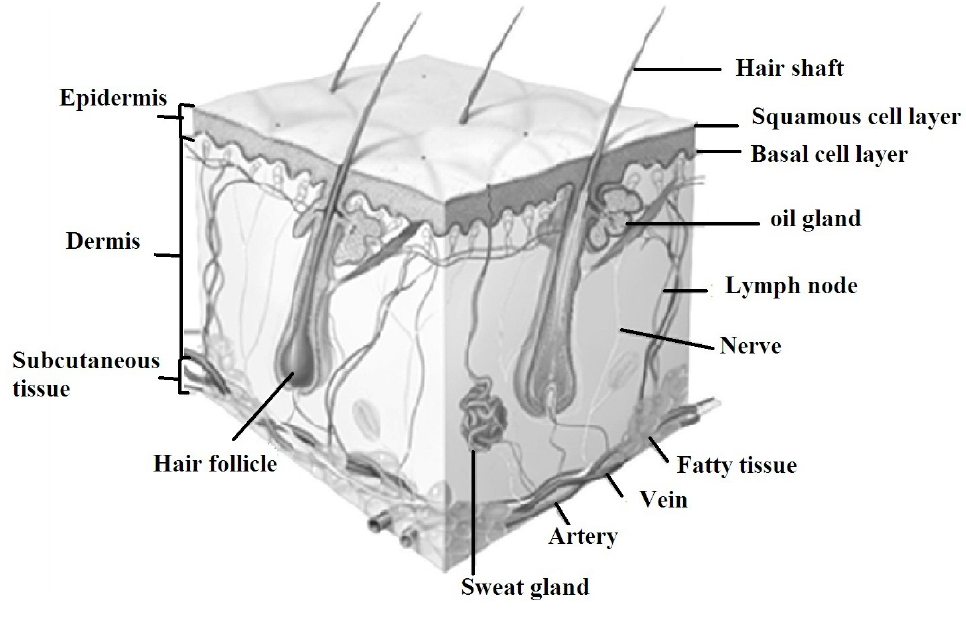
Figure 1. Layers of